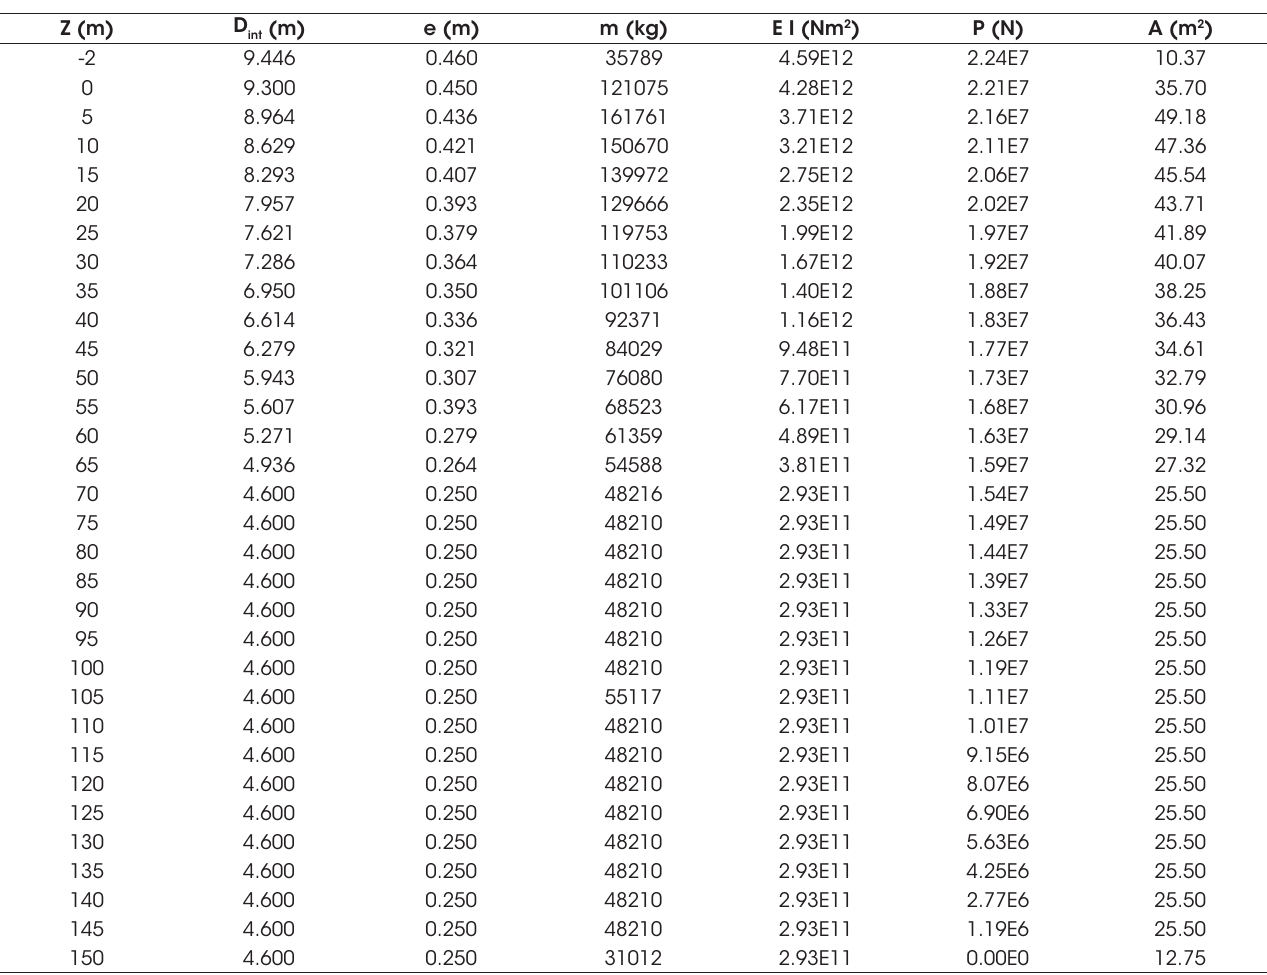
Basic chimney data used in the theoretical